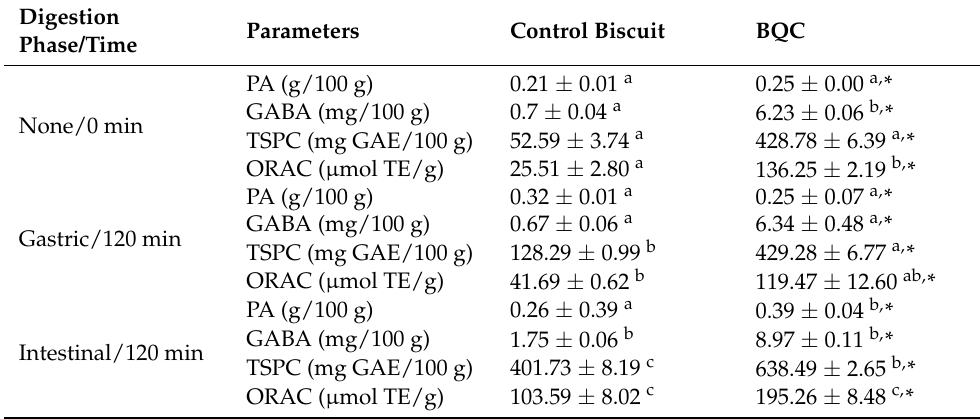
Table 5. In vitro starch digestibility and changes in PA, GABA, TSPCs, and AA during different phases of digestion for control biscuit (100% WF) and BQC prepared with the optimal formulation (15% SQF, 25% SCF, and 60%